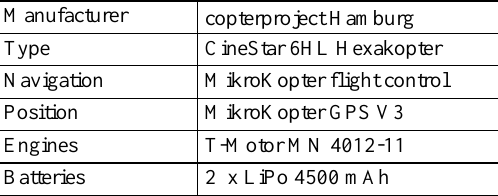
Table 1: Hexakopter technical specifications